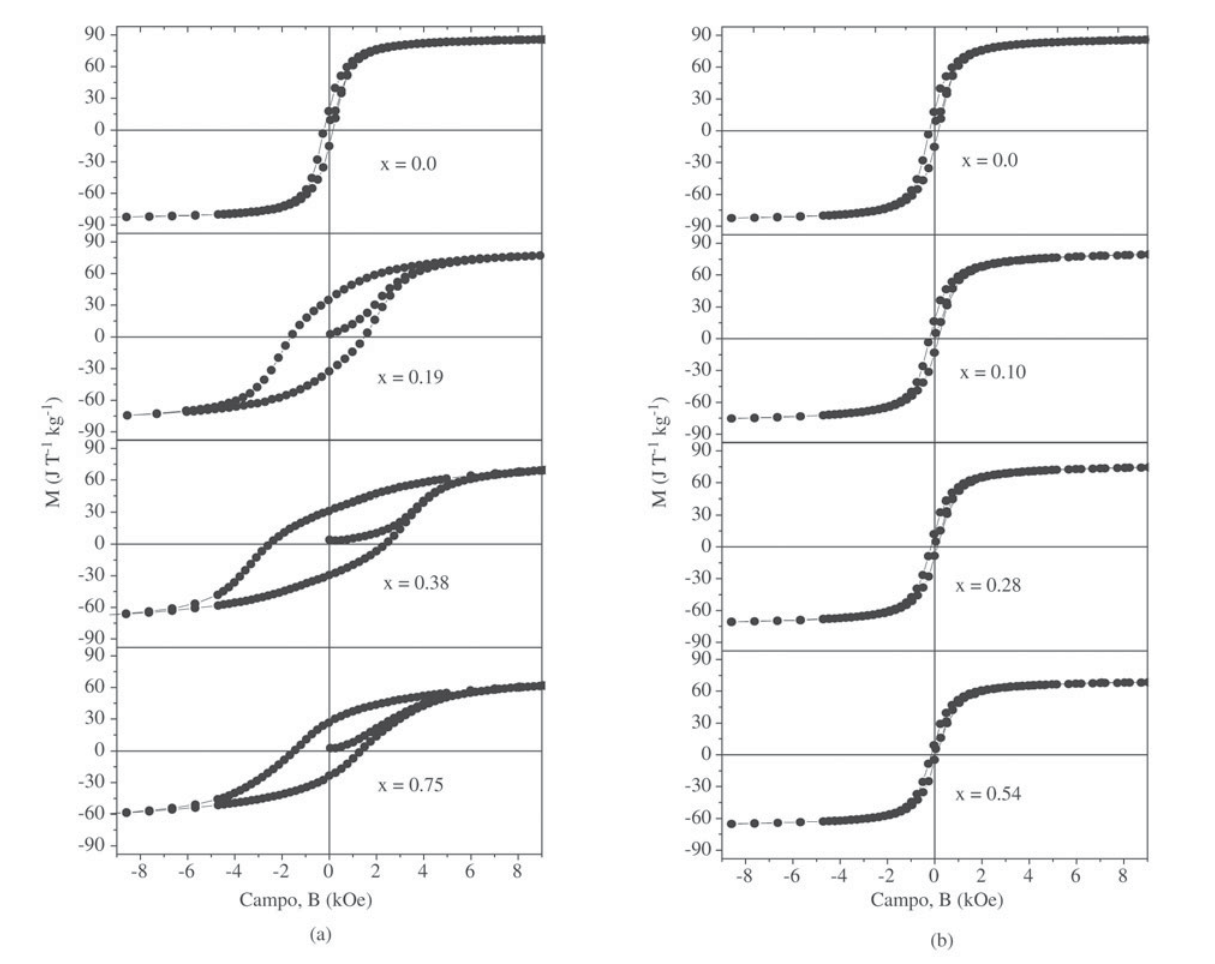
Figure 4. Hysteresis loops recorded at room temperature for the (a) Fe